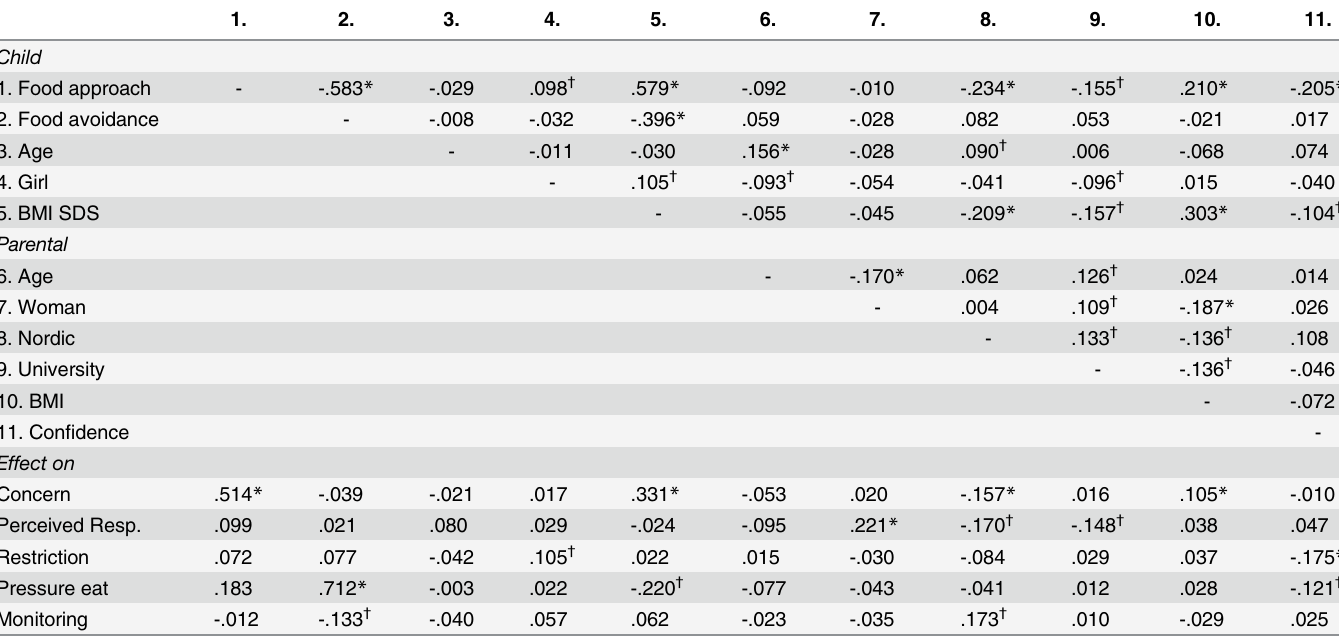
Table 3. Correlations between purely exogenous (independent) variables in the model and their standardized effects on endogenous (dependent) variables.